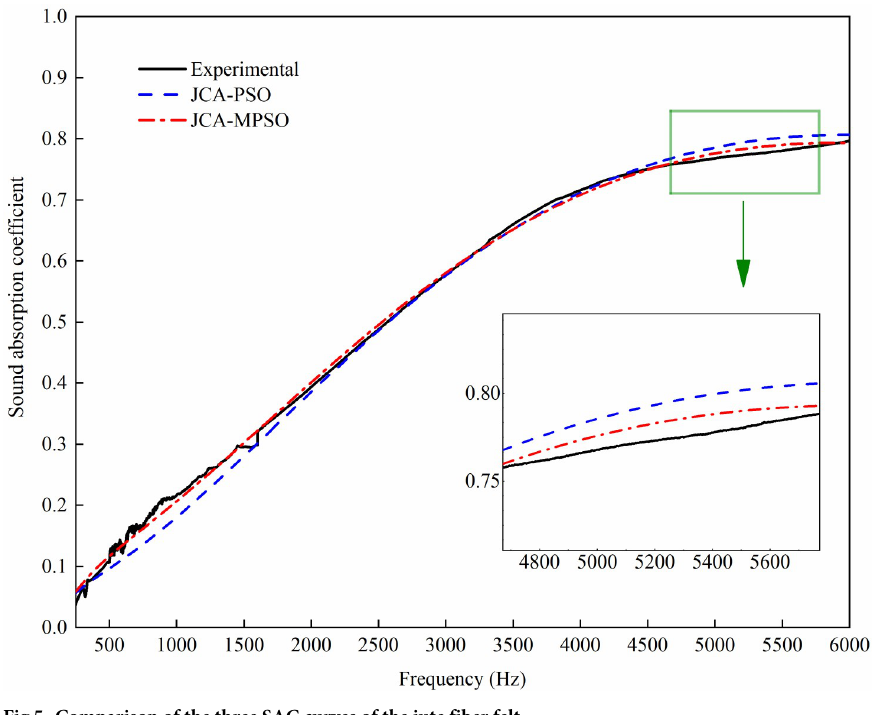
Fig 5. Comparison of the three SAC curves of the jute fiber felt.